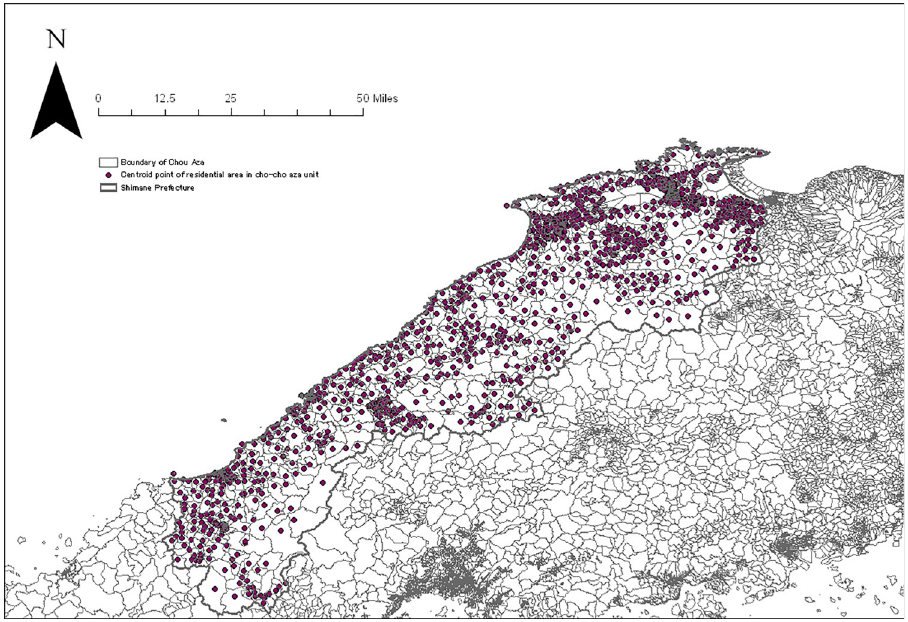
Fig 3. Centroid point of the residential area in each administrative